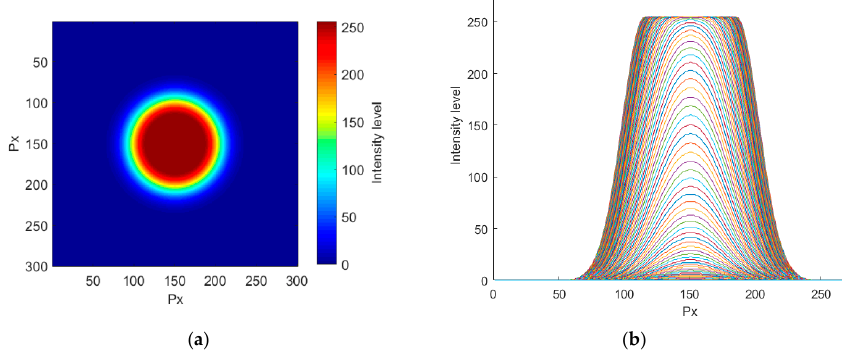
Figure 3. Point design: ( a ) upper view; ( b ) lateral view of its level contour lines.